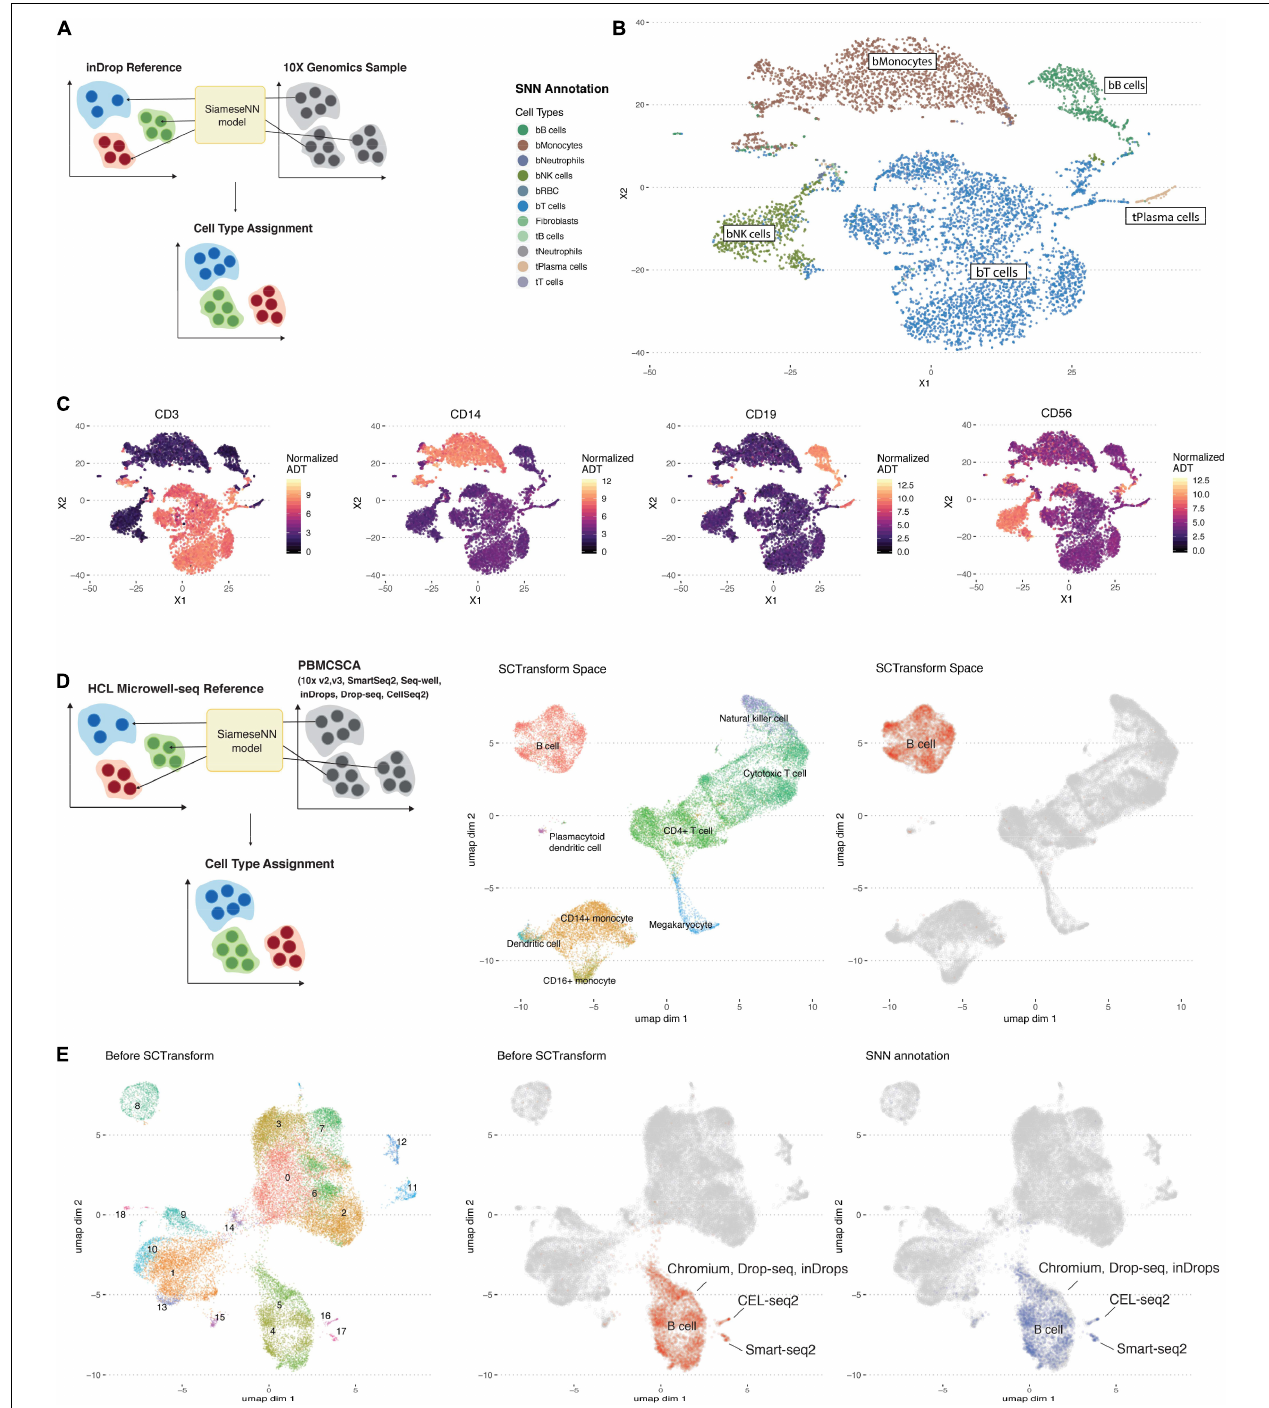
FIGURE 2 | Workflow of the annotation of cell types using MapCell. (A) Each cell to be annotated (10X Genomics sample) is compared to 20 cells from each reference cell type using the learned MapCell model. The reference cell type with the closest average distance is assigned to the cell. (B) t-SNE plot of Siamese Neural Network (SNN) annotated scRNA-seq data from 10X genomics. (C) Cell surface protein expression mapped onto the respective cells in the same t-SNE space. Protein markers exhibit similar boundaries as the predicted annotations by SNN model. (D) (Left) Annotating a set of collated PBMC single-cell RNA data generated from with seven different methods using a SNN model trained on the Microwell-seq HCL PBMC dataset. (Middle) UMAP of combined data after SCTransform. Annotation was provided by Seurat. (Right) UMAP highlighting B Cell cluster after SCTransform. (E) (Left) UMAP of combined data before SCTransform. (Middle) UMAP highlighting B cell annotated cells before SCTransform. Indicated are clusters representing platform-specific batch effects (Right) UMAP highlighting SNN annotation of the B cell clusters before SCTransform.